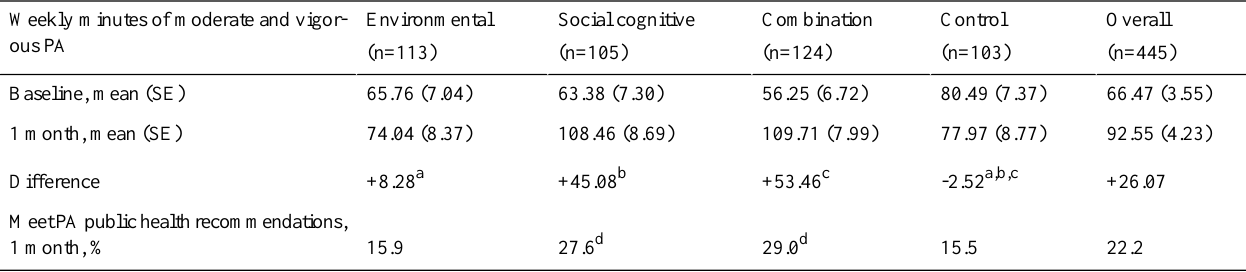
Table 2. Study outcomes by condition and time.